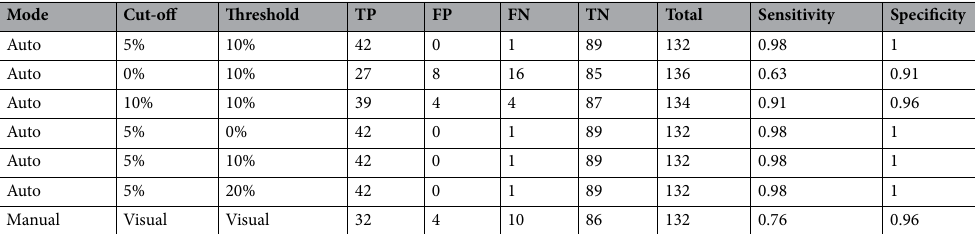
Table 1. Analysis for sensitivity and specificity comparing VAC-surveillance to the gold standard. Cut-off indicates the percentage setting of the lowest outliers being excluded at import. Threshold shows different tolerance threshold settings for including respiratory deterioration as significant according to VAE rules. TP True Positive; FP False Positive; FN False Negative; TN True Negative; VAC Ventilator Associated Condition.